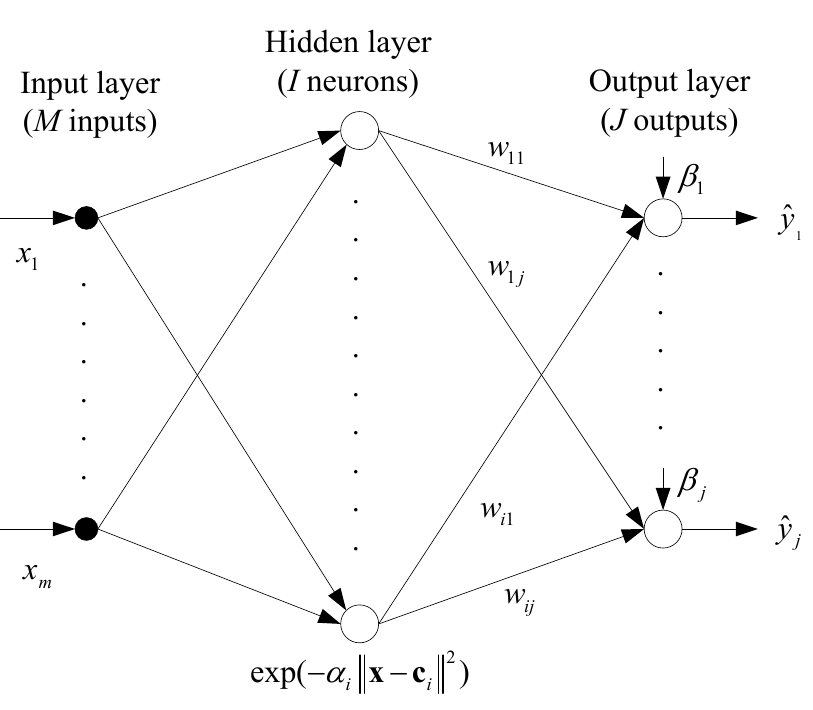
Figure 2. Network architecture of the